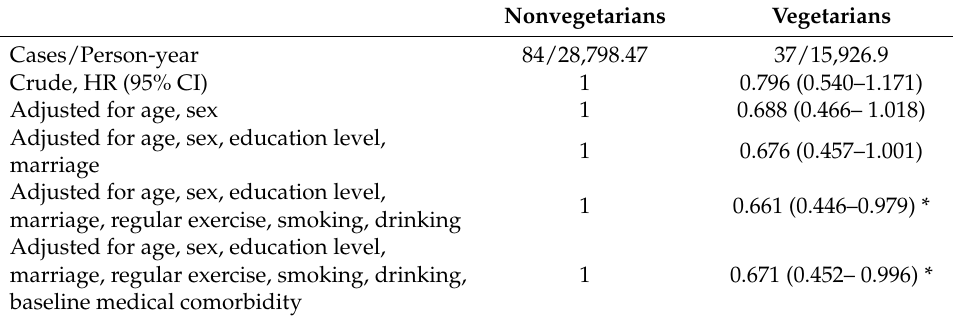
Table 3. Stepwise hazard ratio estimation of dementia risk in vegetarian compared with nonvegetarian.